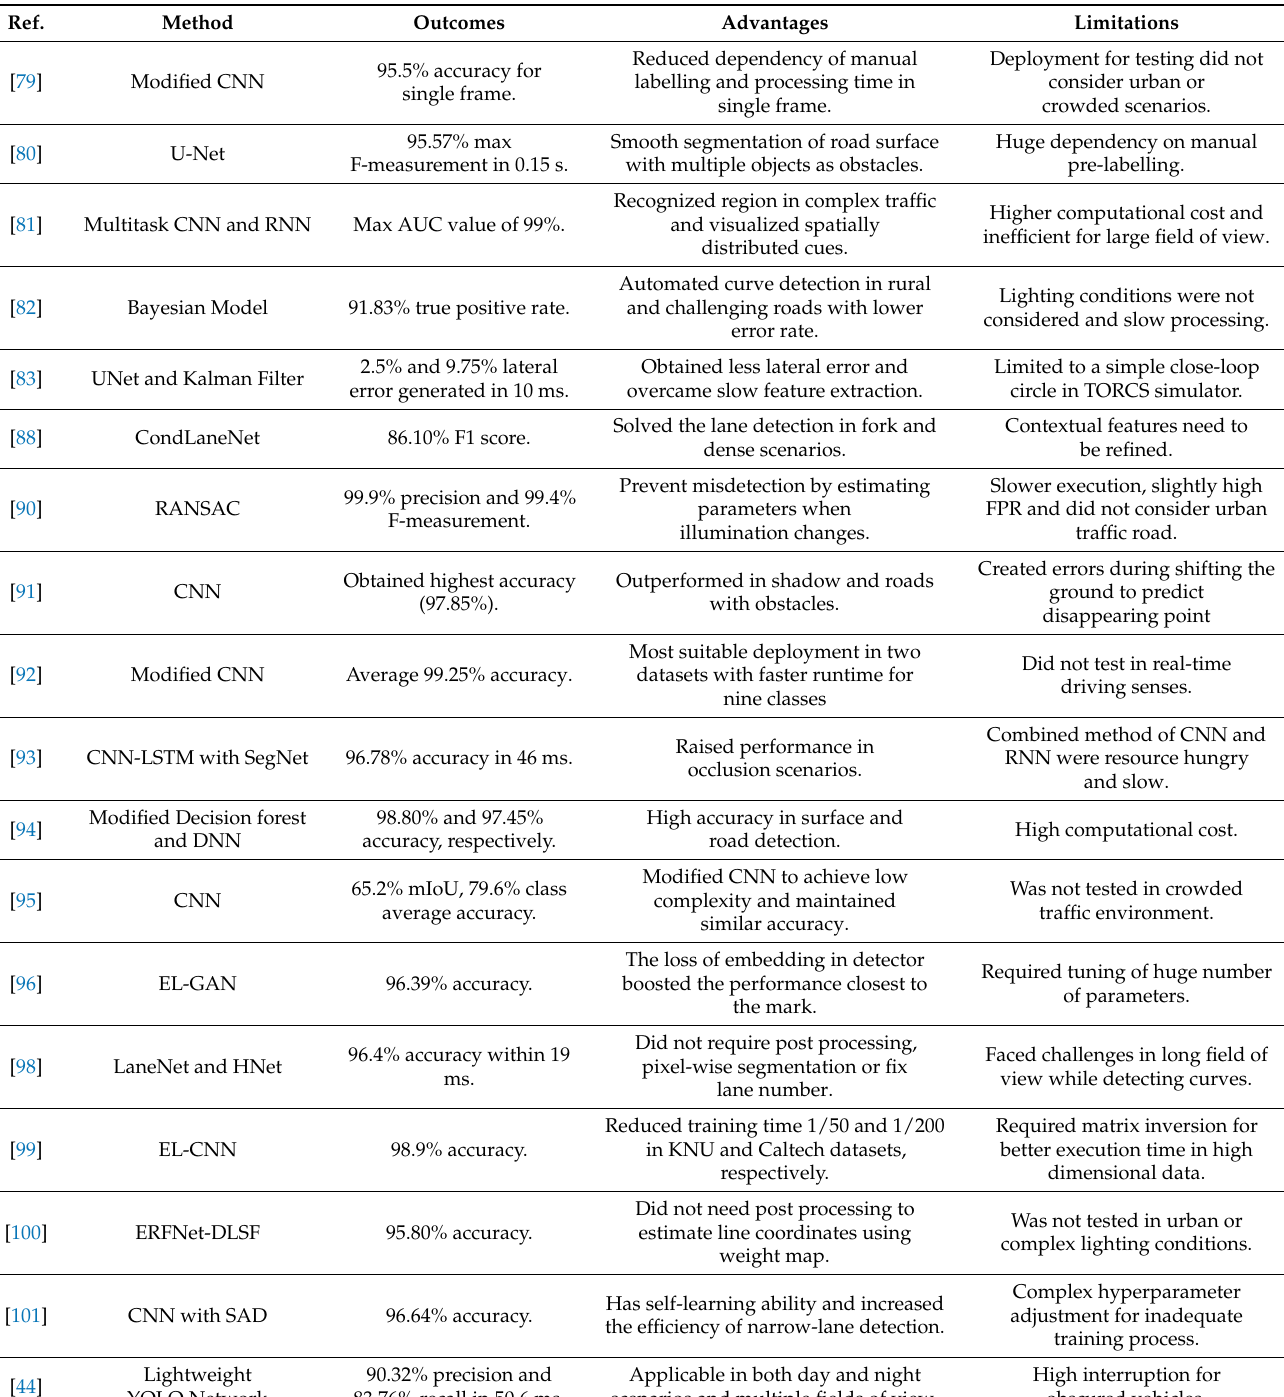
Table 8. Summary of multiple deep learning methods for lane detection and